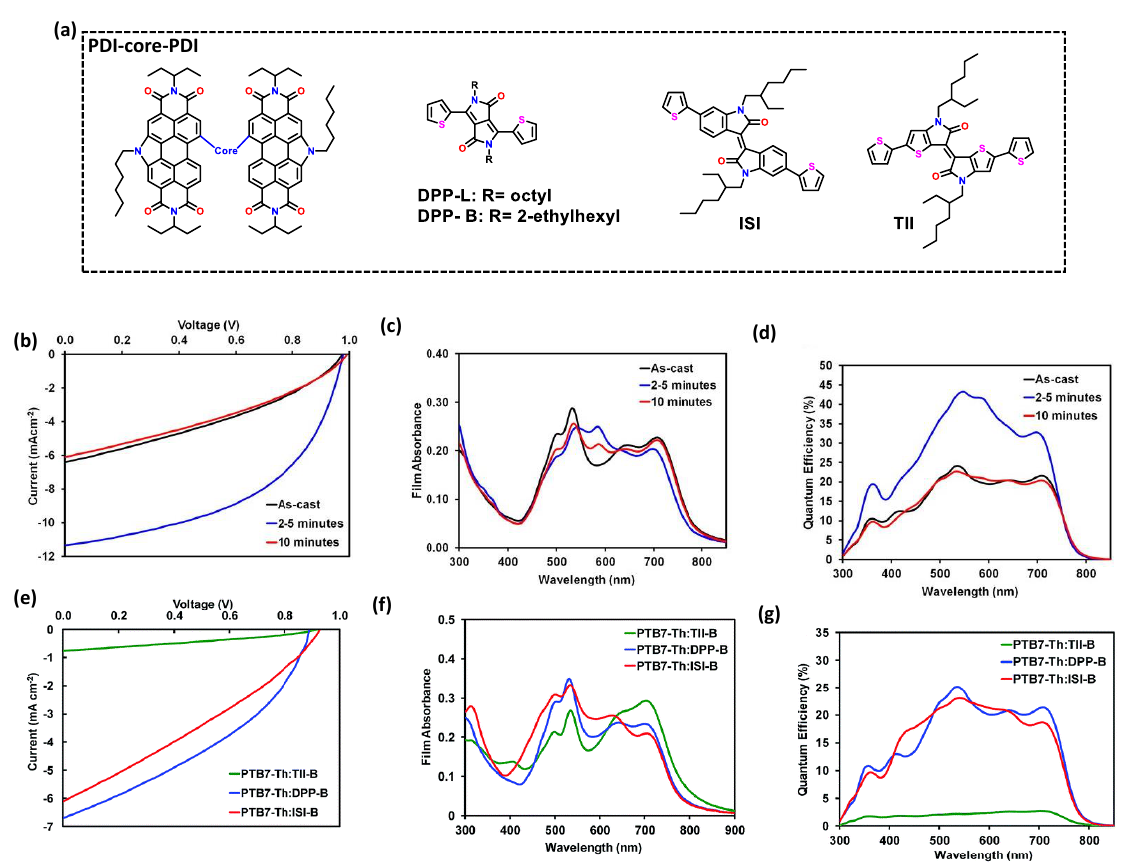
Figure 6. ( a ) General chemical structure of the PDI-Core-PDI framework and chemical structure of DPP-L (R = Octyl), DPP-B (R = 2-ethylhexyl), ISI-B, and TII-B dye cores used in PDI-core-PDI dimers. ( b ) Device J–V curves, ( c ) film UV–Vis absorption spectra, and ( d ) device EQE of PTB7-Th:PDI-DPP- PDI blends before and after SVA. ( e ) Device J–V curves, ( f ) film UV–Vis absorption spectra, and ( g ) device EQE of PTB7-Th:PDI-X-PDI blends where X = TII-B, DPP-B, ISI-B [84,86,87]. ( b – d ), and ( e – g ) reproduced with permissions from [84],[86] respectively. Copyright 2017 American Chemical Society and 2017 Royal Society of Chemistry.